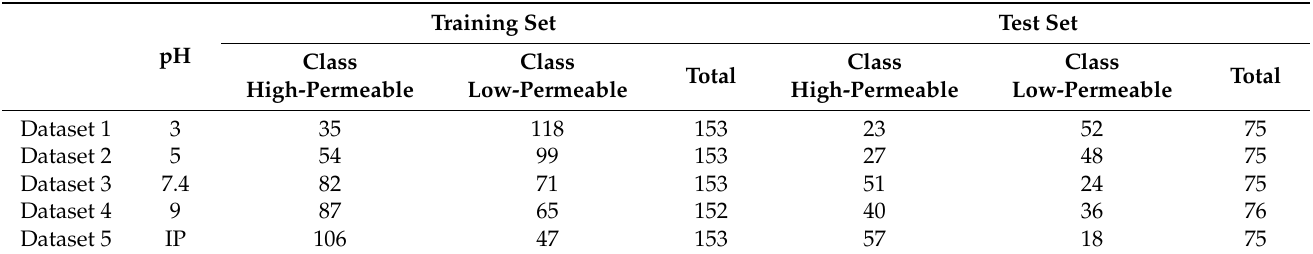
Table 2. Distribution of the samples into the two classes at the different pH levels for the training and the test set.